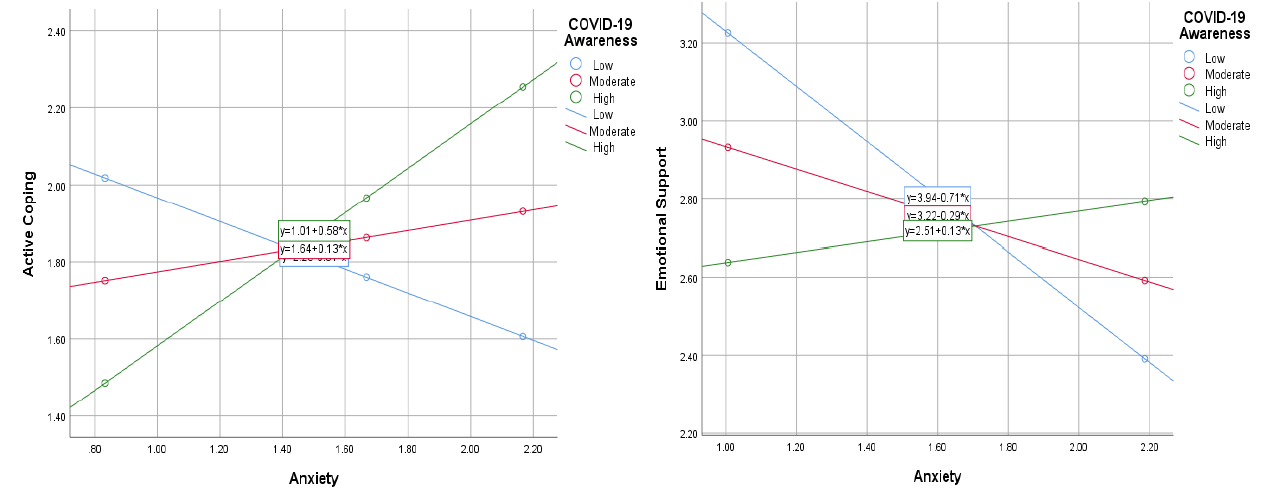
Figure 1. Probing the effect of the significant moderation